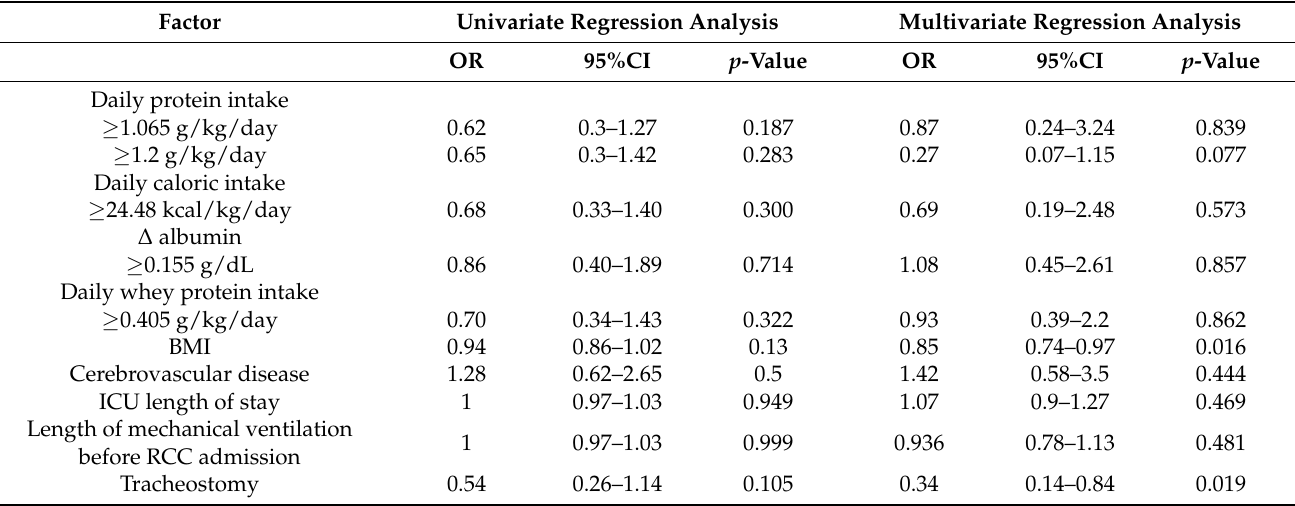
Table 3. Factors associated with hospital mortality.